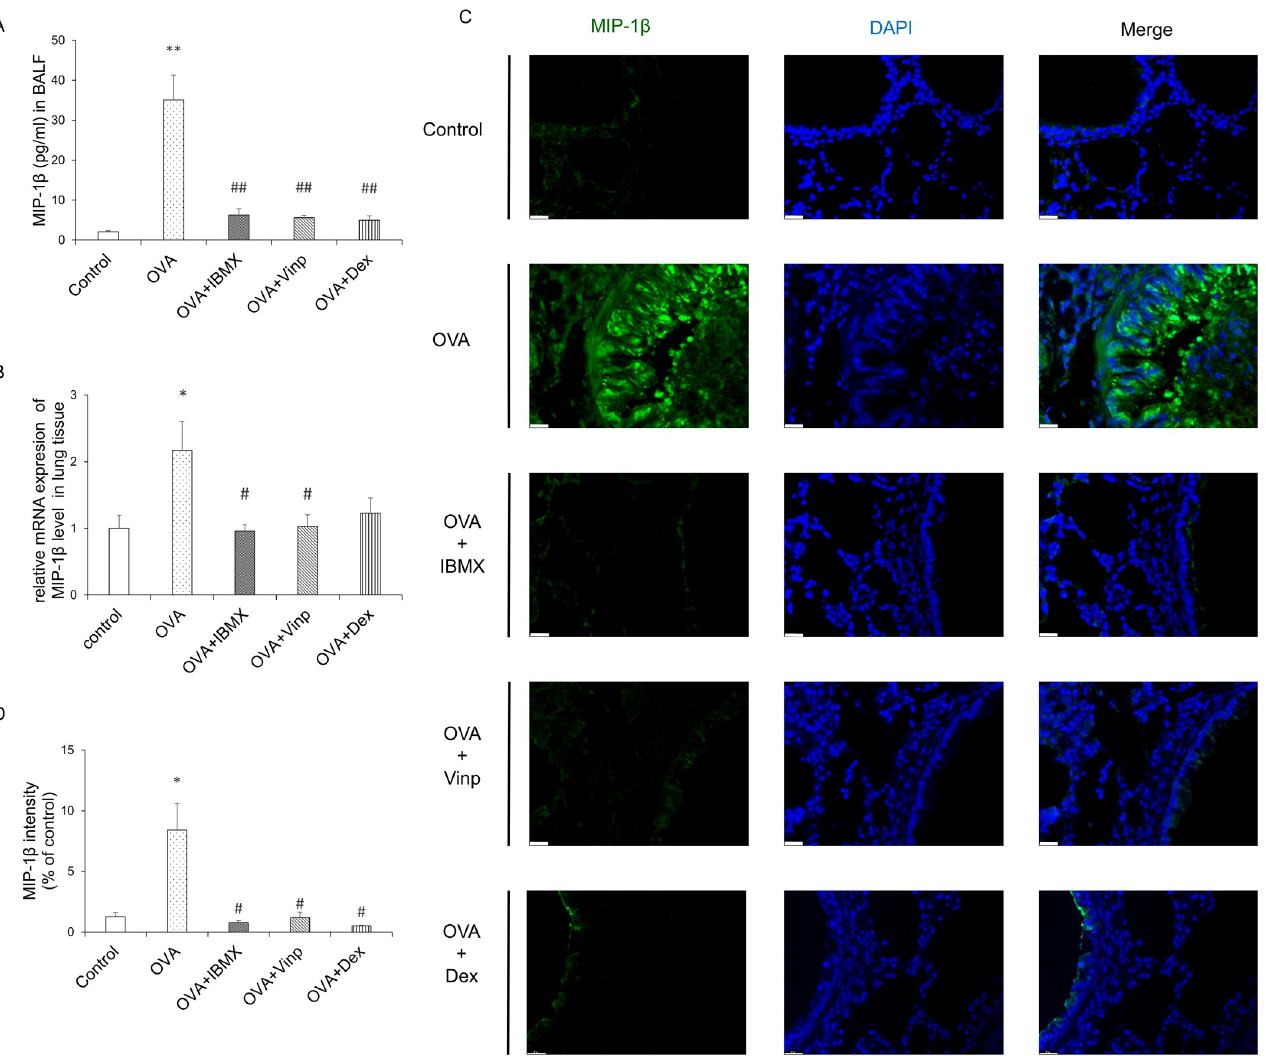
Fig 4. Effects of IBMX and Vinp on MIP-1 β expression and release in eosinophilic lung inflammation. ( A ) MIP-1 β in BALF was measured by ELISA. ( B ) The mRNA expression level of MIP-1 β in lung tissues was measured by RT-qPCR. ( C ) MIP-1 β expression in lung tissue was detected by immunofluorescence staining (magnification, 63 × ; scale bar, 20 μ m). ( D ) In immunofluorescence-stained tissue, the green fluorescence intensity of stained images was measured using ImageJ. Data are expressed as mean ± SEM. Statistical analysis was performed using one-way ANOVA (Data were considered significant at �� P < 0.01 compared with the control group and # P < 0.05 compared with the OVA group). IBMX, 3-isobutyl-1-methylxanthine; BALF, broncho-alveolar lavage fluid; Vinp, vinpocetine; MIP-1 β , macrophage inflammatory protein-1 β ; OVA, ovalbumin; Dex, dexamethasone.